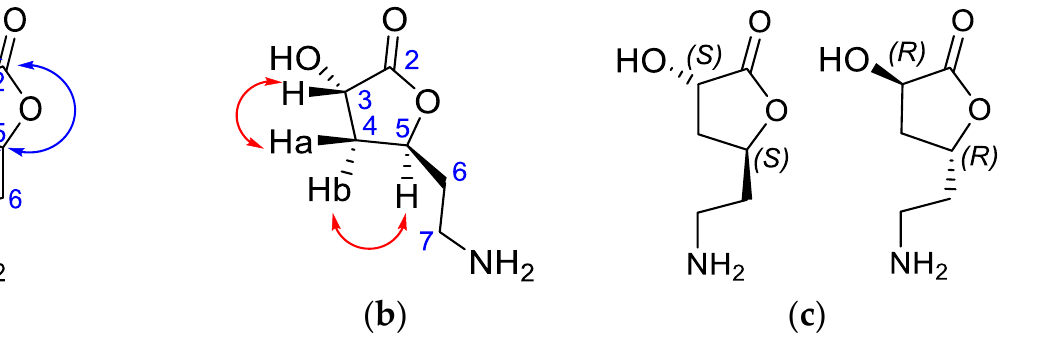
Figure 5. Structural assignment for LF-MeOH-D, 9. ( a ) HMBC ( ↔ ) correlation, ( b ) NOESY ( ↔ ) information, and ( c ) two possible conformations of 9 . Table 5. The 1- and 2-D NMR data of isolate from LF-MeOH-D in D 2 O (400 MHz).